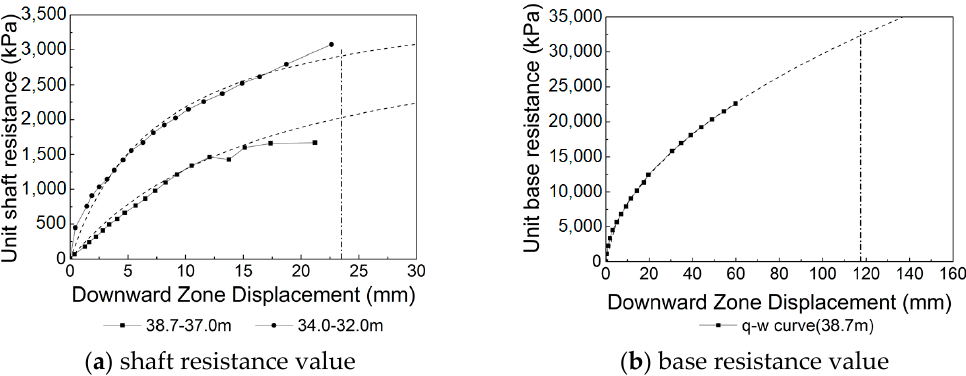
Figure 8. Determination of the ultimate shaft and base resistance values for TP 1.